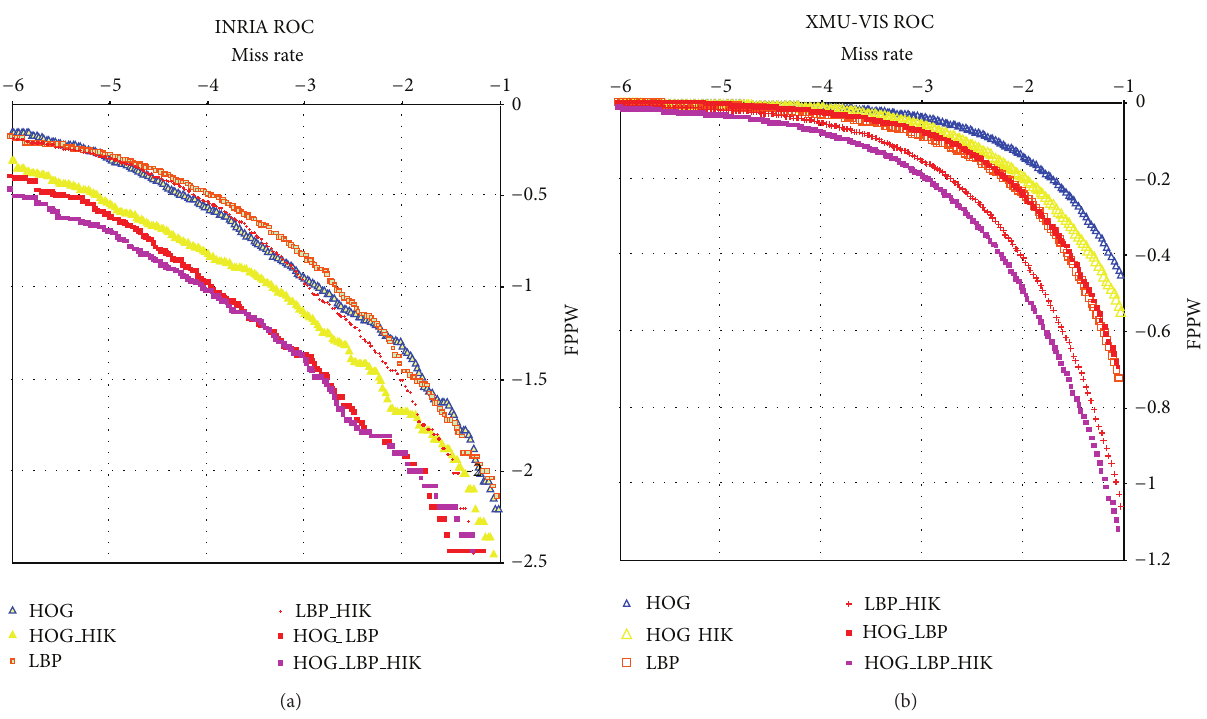
Figure 6: Comparing accuracies achieved by applying single features (HOG and LBP) and fusing features (HOG + LBP) using HIKSVM and FF1 to INRIA and XMU-VIS datasets.